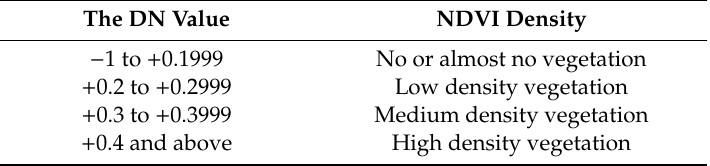
Table 1. Categories of the Normalized Di ff erent Vegetation Index (NDVI)